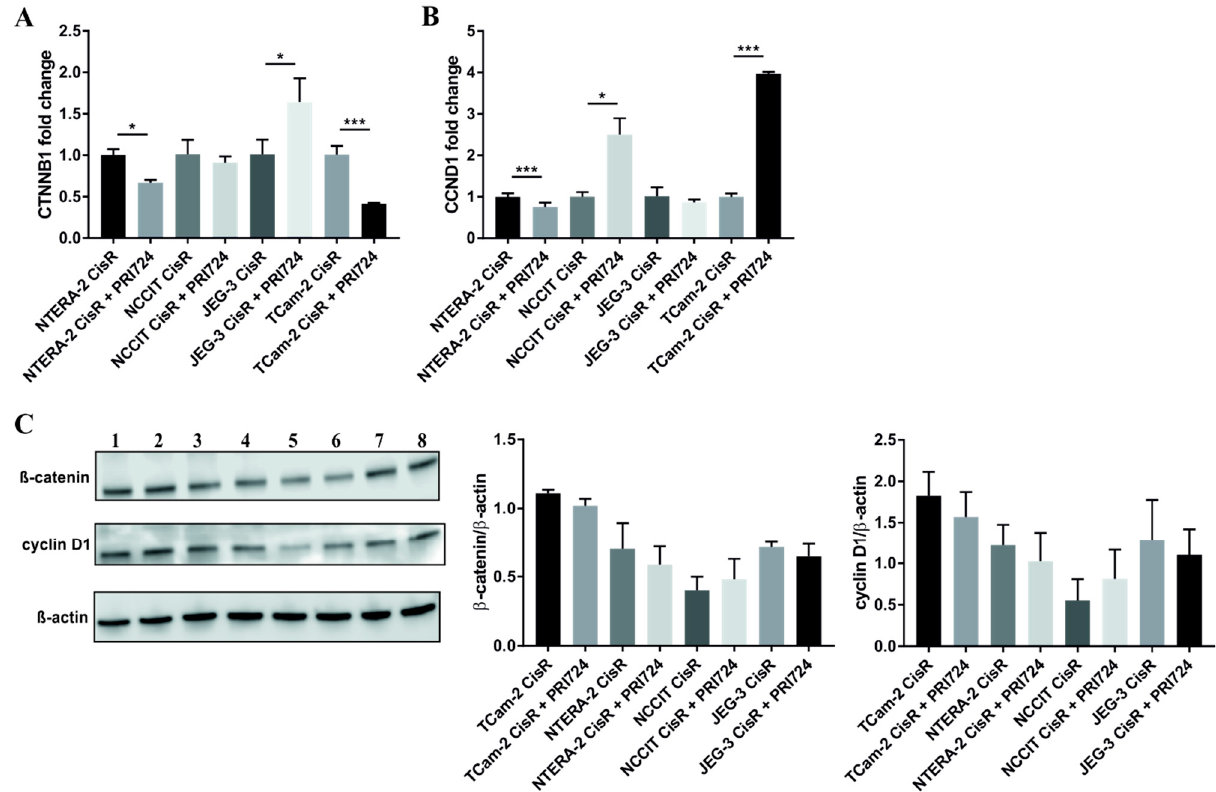
Figure 9. PRI-724 treatment did not affect protein levels of β -catenin and cyclin D1 in GCT cell lines. ( A ) qPCR analysis revealed significant decrease in expression of CTNNB1 in NTERA-2 CisR and TCam-2 CisR cells and increased CTNNB1 expression in JEG-3 CisR cells treated with PRI-724 inhibitor. ( B ) Decreased CCND1 expression was confirmed in NTERA-2 CisR cells after PRI-724 treatment. Significant upregulation was detected in PRI-724 treated NCCIT CisR and TCam-2 CisR cells. ( C ) Western blot and densitometric analysis confirmed that PRI-724 treatment did not change the protein levels of β -catenin and cyclin D1 in GCT cell lines. 1. TCam-2 CisR; 2. TCam-2 CisR + PRI-724; 3. NTERA-2 CisR; 4. NTERA-2 CisR + PRI-724; 5. NCCIT CisR; 6. NCCIT CisR + PRI-724; 7. JEG-3 CisR; 8. JEG-3 CisR + PRI-724. β -actin was used as an internal loading control. * p < 0.05, ** p < 0.01, *** p < 0.001.